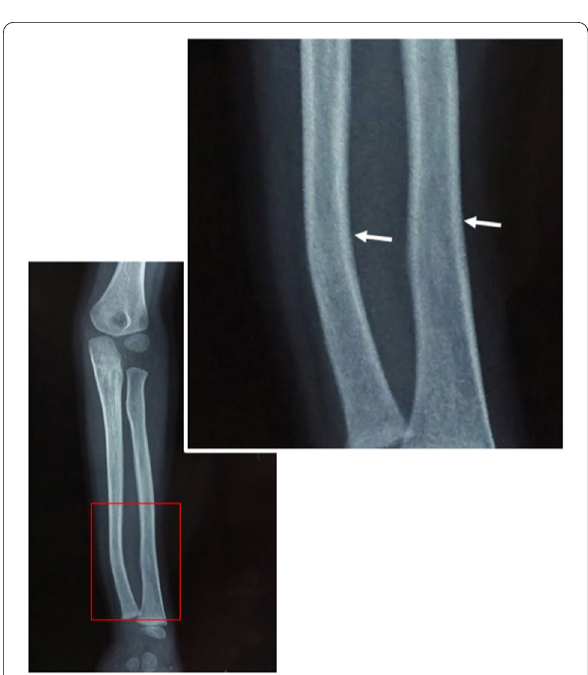
Fig. 4 Plastic deformation. Forearm anteroposterior x-ray shows lateral bowing of the distal ulnar and radial diaphyses (white arrows), without identifying any fracture